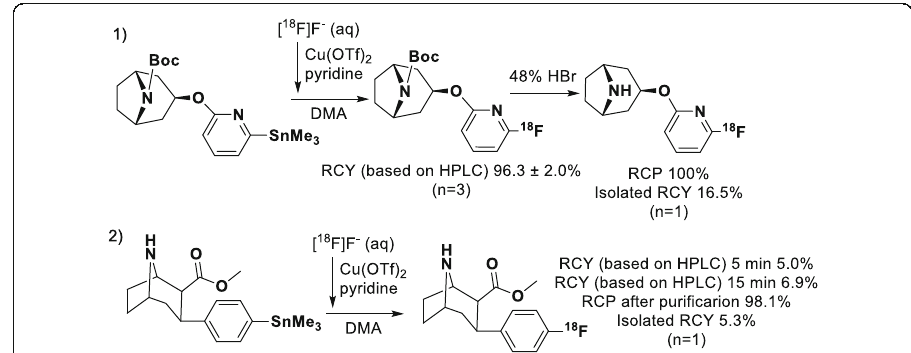
Fig. 2 Copper-mediated radiofluorination of 1) [ 18 F]NS12137 with 5 min reaction and 5 min acid hydrolysis and purification, and 2) [ 18 F]CFT with 5 to 15 min reaction and purification. Reaction conditions for both: 1 eq precursor, 5 eq Cu(OTf) 2 , 75 eq pyridine, 120